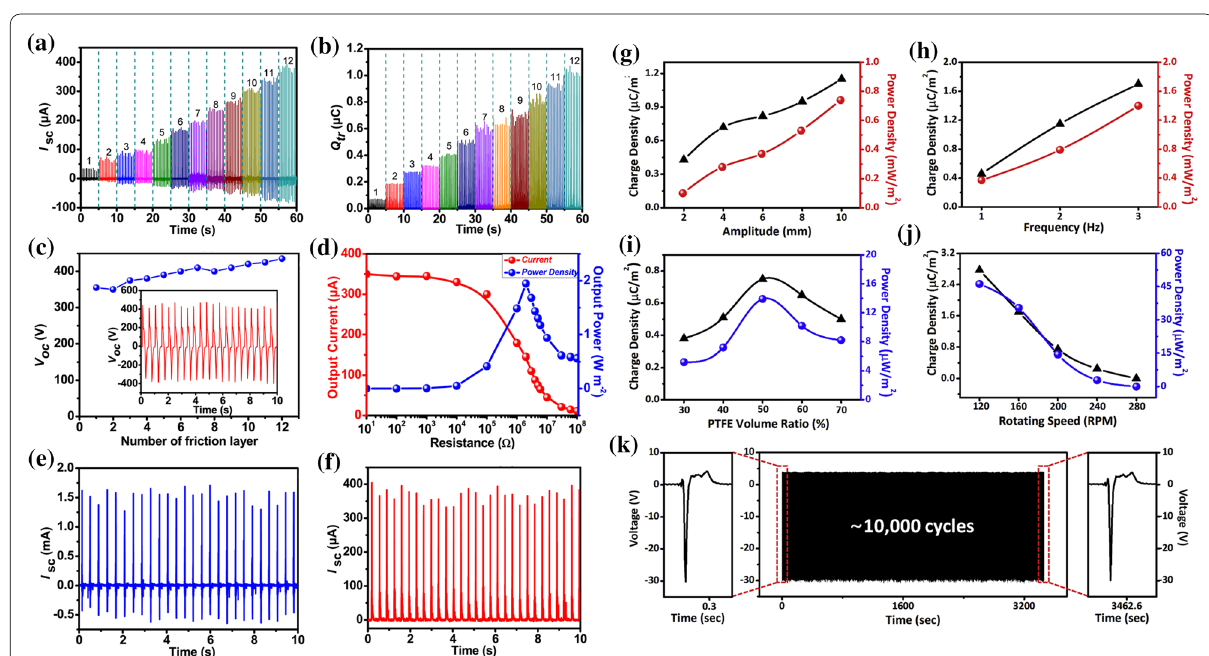
Fig. 13 Output performance characteristics of the 3DP-TENG proposed by Tian et al. [147]: a short-circuit current, b induced charge c open-circuit voltage with twelve different pairs of fraction layers, d output current and power density with the external resistance e , the transformed short-circuit current, and f rectified short-circuit current [147]. Electrical performance of the 3DP-NMEH proposed by Hong et al. [148] under various test conditions: The induced charge density and powder density under the vertical operational mode and various: g amplitudes (2–10 mm) h frequencies (1–3 Hz), charge and powder densities achieved by the device under rotational working mode and various: i Teflon volume ratios the permission of the